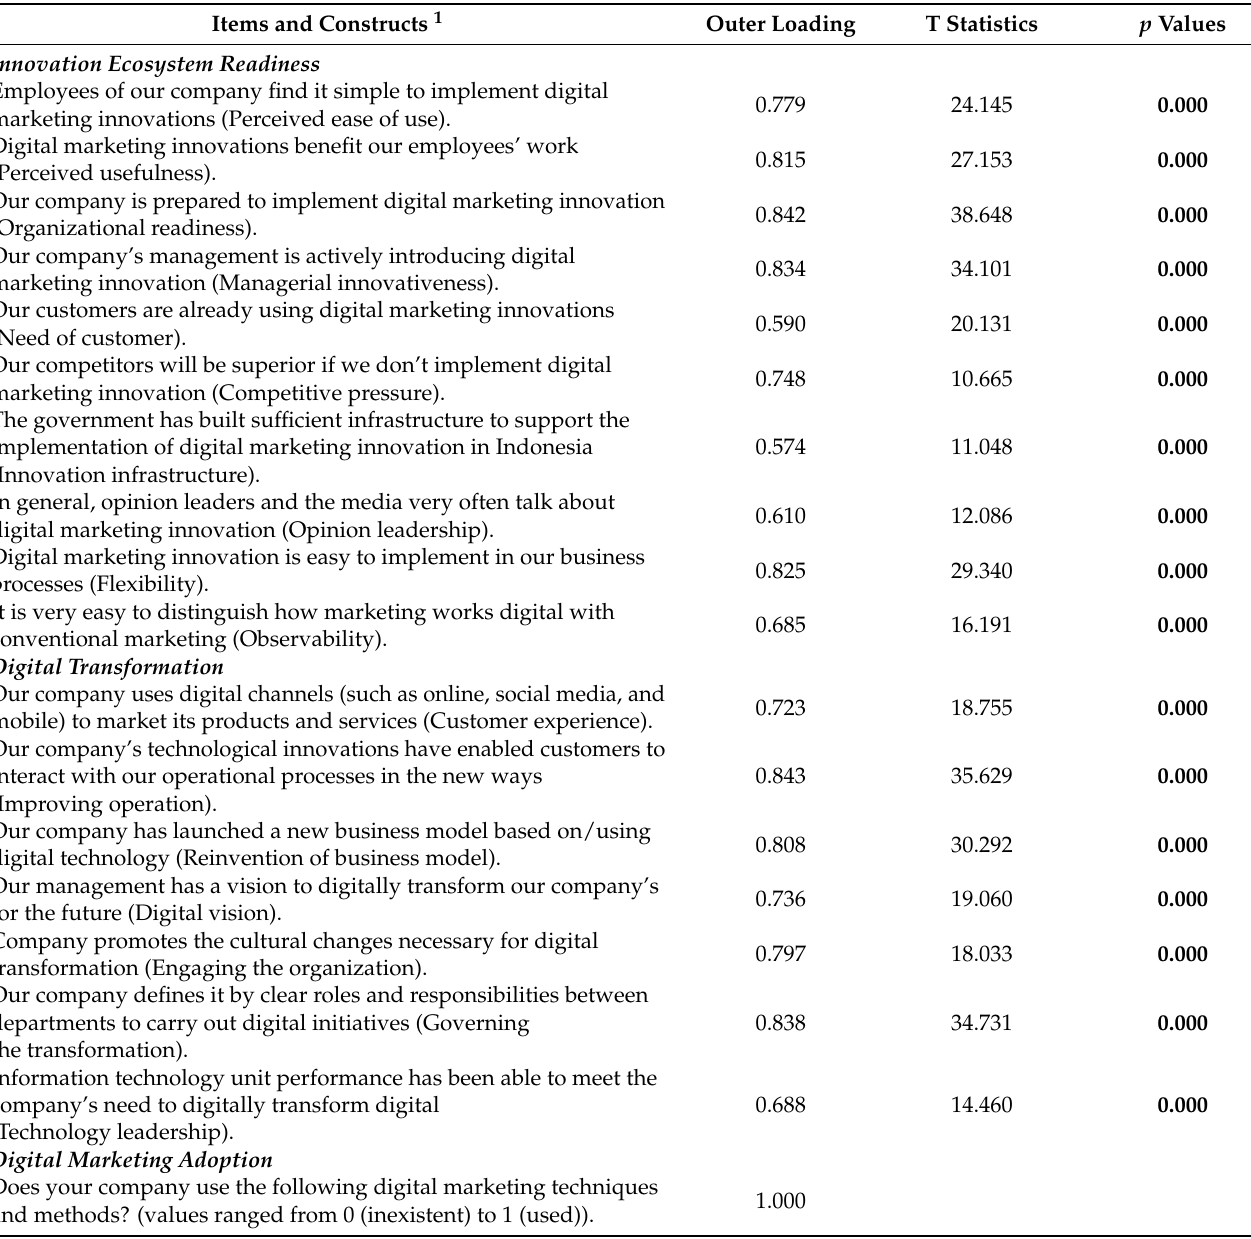
Table 2. PLS-SEM Results: size and significance of outer